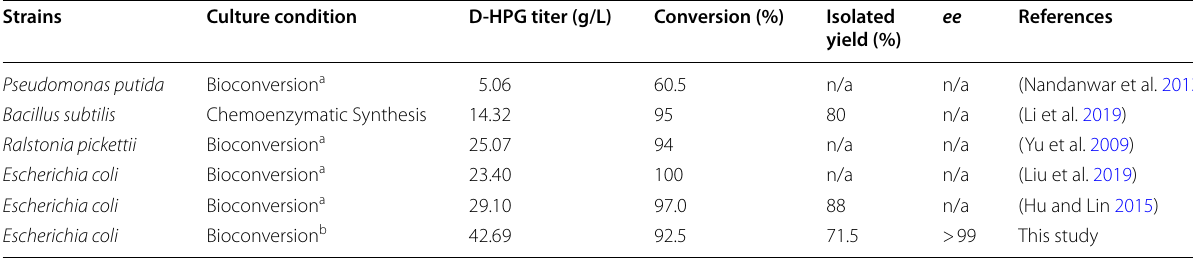
n/a: not available a Dual-enzyme cascade employing Hase and Case b Four-enzyme cascade in this study